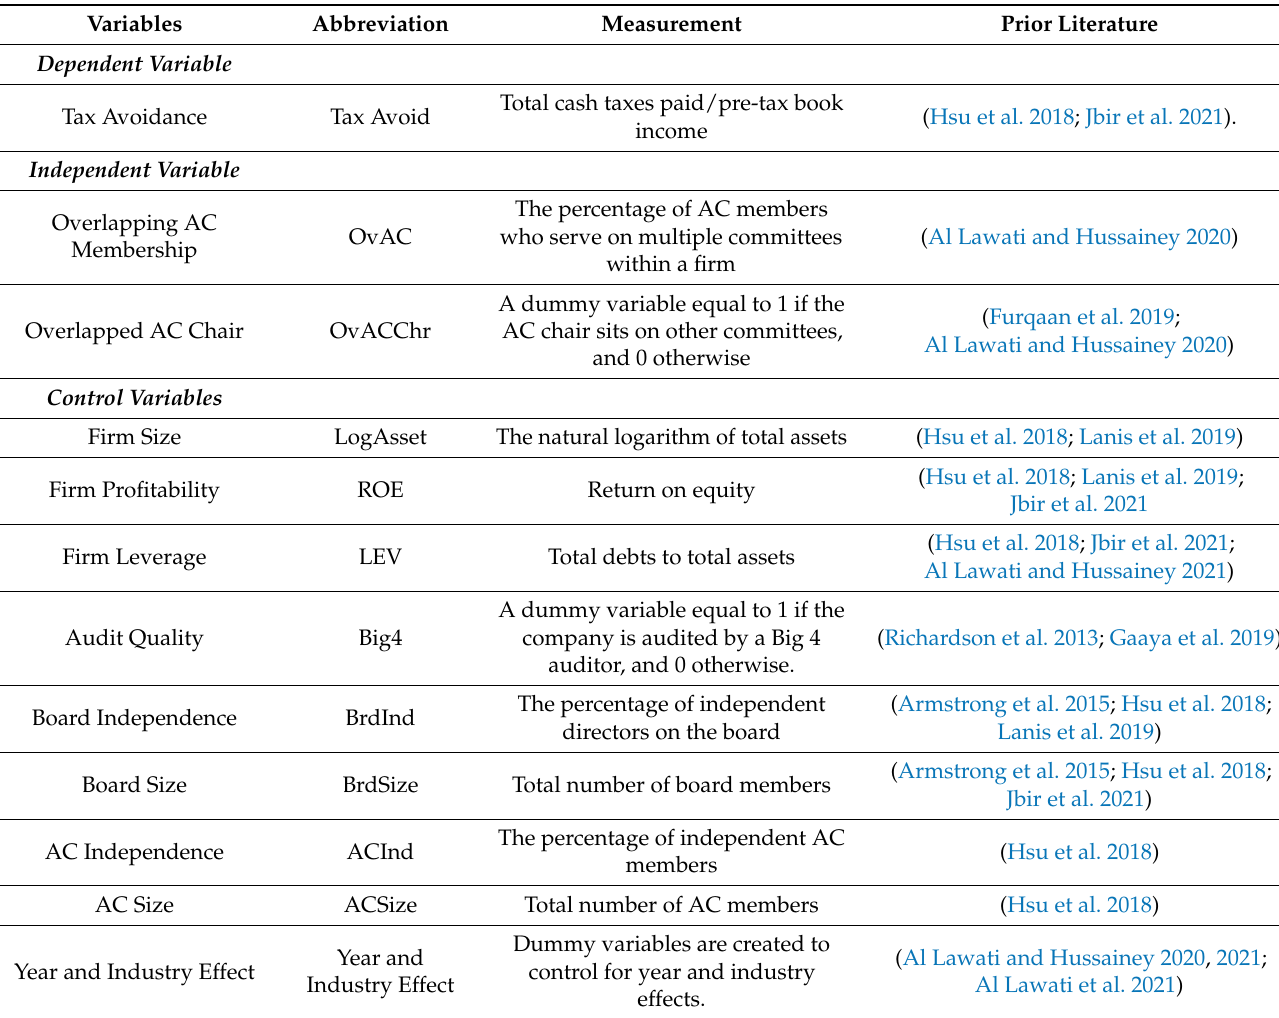
Table 1. Variable measurement and